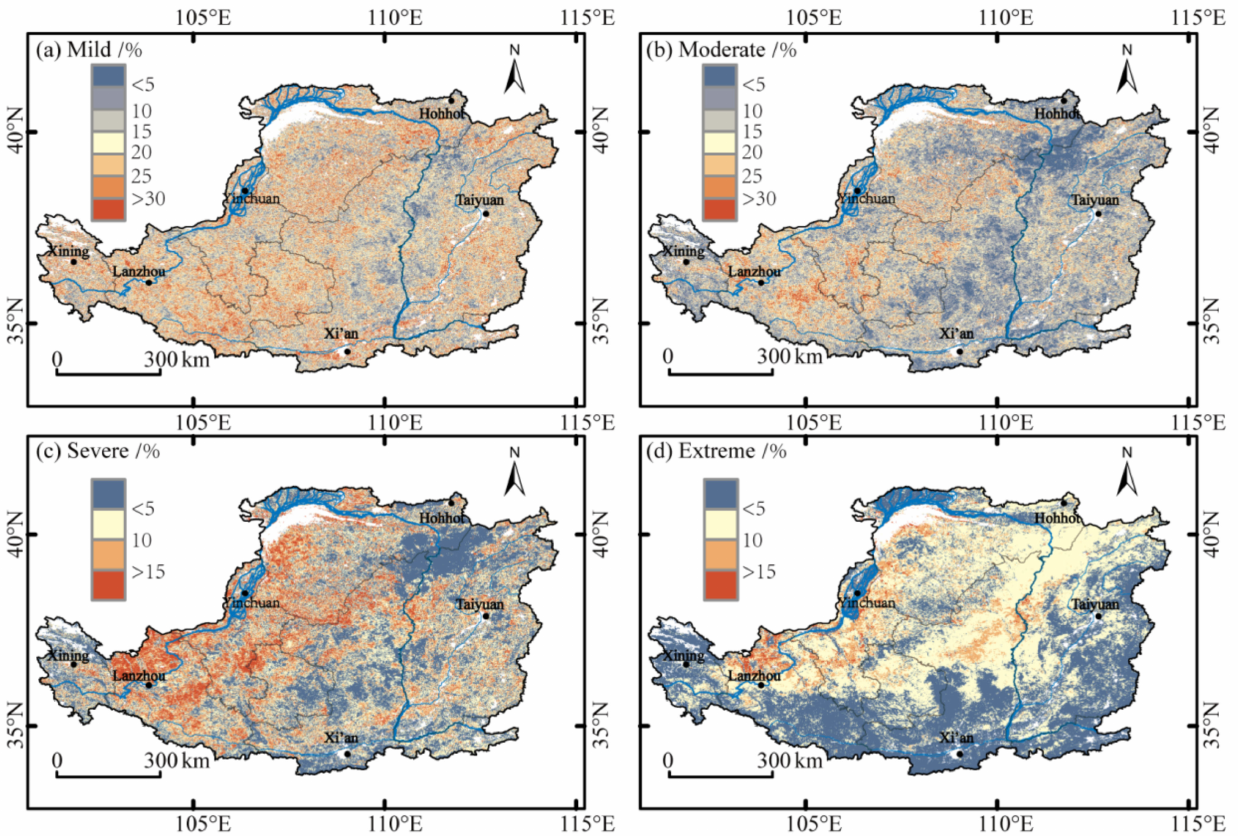
Figure 9. Spatial pattern of drought frequencies for various drought grades during vegetation growing period according to VCI values across the Loess Plateau. ( a ) Occurrence frequency of mild drought; ( b ) occurrence frequency of moderate drought; ( c ) occurrence frequency of severe drought; ( d ) occurrence frequency of extreme